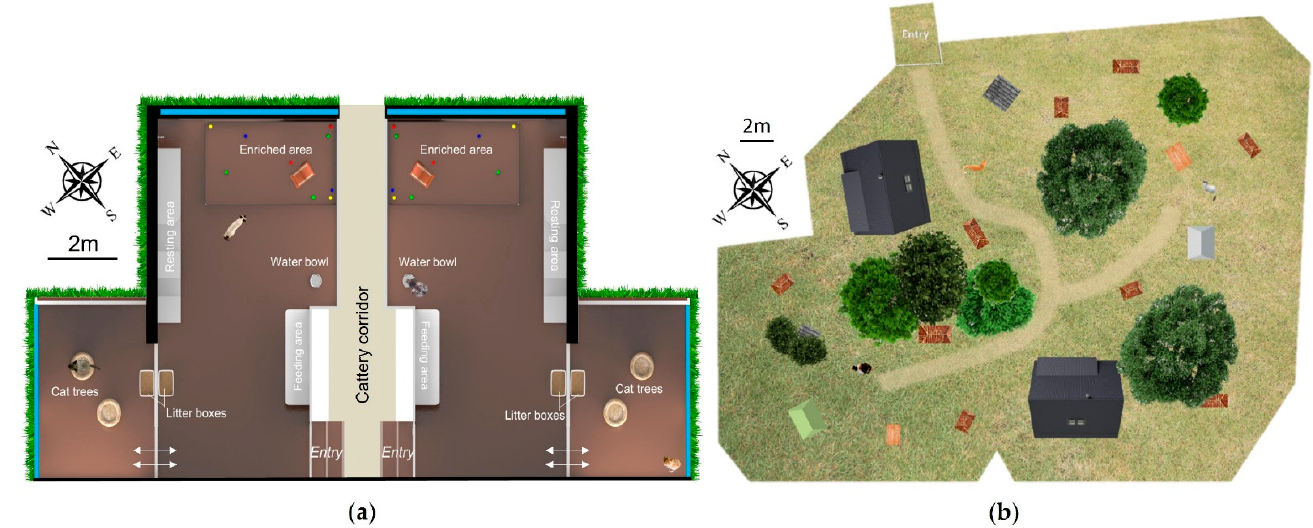
Figure 1. Maps of the (a) indoor panels and ( b ) outdoor enclosure. The indoor cats were exposed through large windows to natural light/dark cycle, with an average of 14 h 56 min of light per day, daily varying on average from 21–608 lux (Figure 2). Ambient temperature and relative humidity were controlled in the main room, varying on average from 22.8–23.2 °C and from 60–66%, respectively. The outdoor indi- viduals were exposed to climate conditions, receiving on average 15 h 36 min of light per day with ambient temperature daily varying on average from 12.8–30.9 °C, humidity from 44–95% and light from 7–2283 lux (Figure 2).